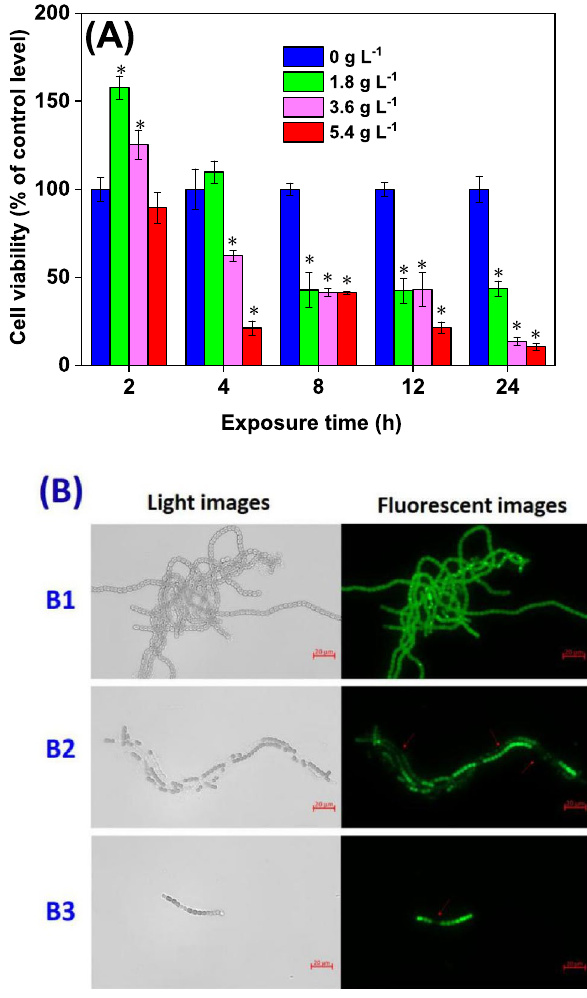
Figure 2. Cell viability of Dolichospermum flos-aquae treated with aqueous extract of watermelon peel (WMPAE): ( A ) Quantitative measurement results (Data are shown as mean ± standard deviation for n = 3, * indicates p < 0.05); ( B ) Light images and fluorescent images of algal cells in 0 g L −1 and 5.4 g L −1 WMPAE group: B1, cells in 0 g L −1 group; B2, cells in 5.4 g L −1 group for 24 h; B3, cells in 5.4 g L −1 group for 48